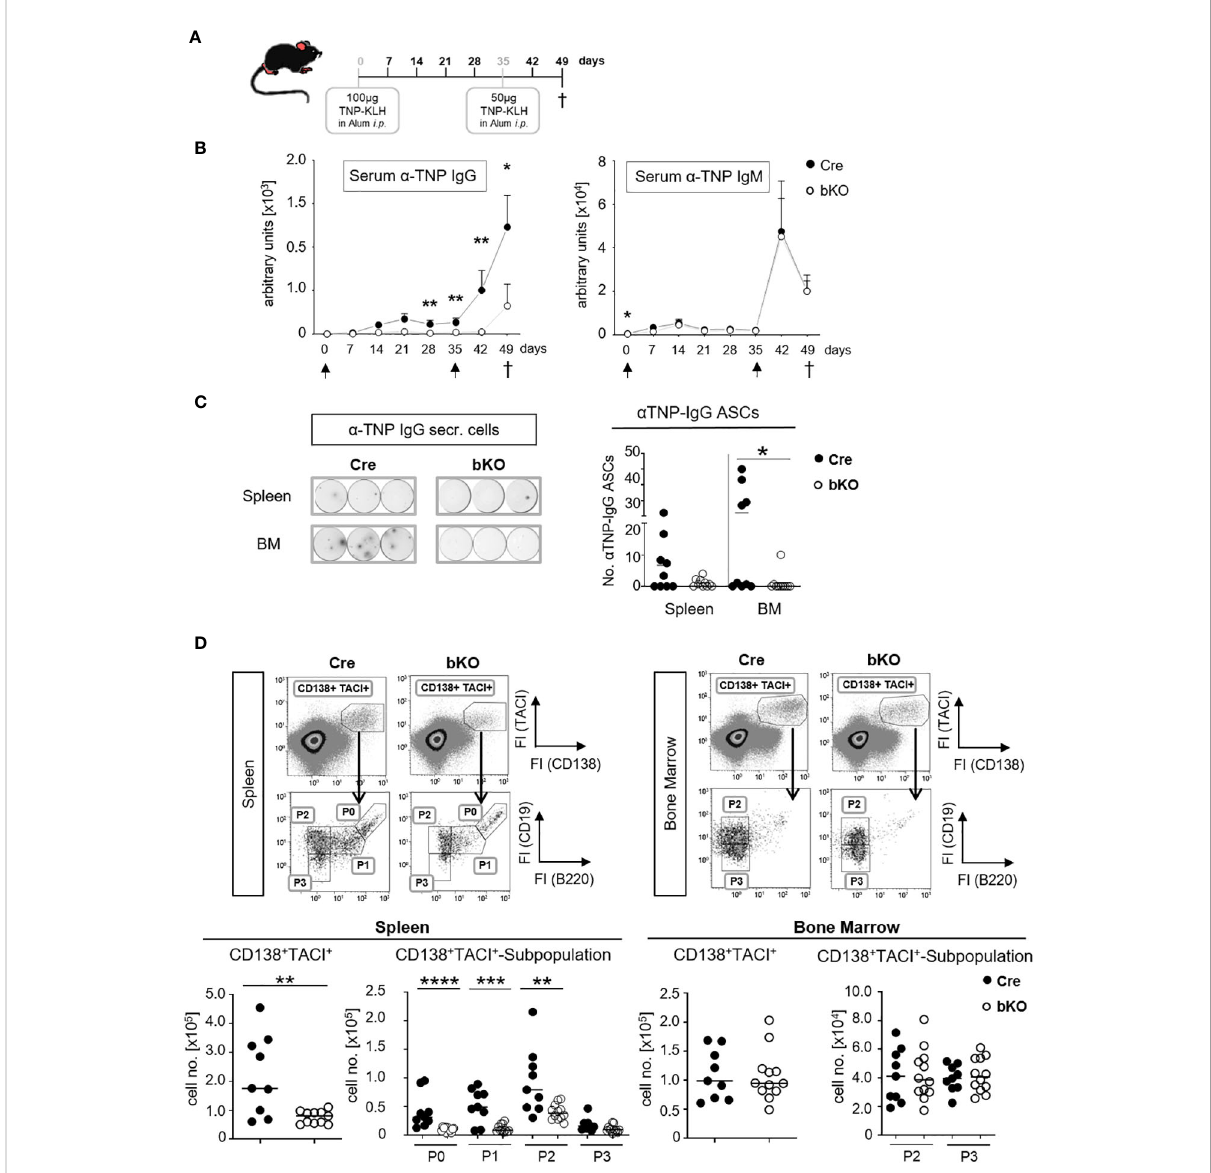
FIGURE 3 CD23-Cre-mediated DGCR8-de fi cient mice fail to mount a TD antigen-speci fi c IgG response. (A) DGCR8-bKO and Cre control mice (9-18 weeks in age) were injected intraperitoneally with TNP-KLH in alum, boostered on day 35 and sacri fi ced 49 days after primary immunization. (B) Blood was collected weekly, and sera were analyzed for TNP-speci fi c IgG and IgM by ELISA. Arrows indicate immunization time points. Each dot represents the mean (+SEM) of n=9 (Cre) or n=12 (bKO) mice. (C) Mice were sacri fi ced on day 49 p.i. (post-immunization), spleen and bone marrow (BM) cell suspensions were analyzed for TNP-speci fi c IgG-secreting cells by ELISpot assay. The examples show the results obtained from 6,67x10 5 cells incubated per well. Cell numbers are calculated per 2x10 6 seeded cells. (D) Flow cytometric analysis of splenic and bone marrow cells. Antibody-secreting cells were de fi ned as CD138 + TACI + cells and further divided by CD19 and B220 surface abundances in P0- activated B cells, P1-plasmablasts, P2-early plasma cells and P3-mature plasma cells (26). Cell numbers were calculated for one tibia and one femur or the entire spleen. (C, D) Bars indicate the median of n=9 (Cre) or n=12 (bKO) mice from N=3 experiments. Each dot represents an individual mouse. Maximal one signi fi cant outlier per genotype and analysis was removed from the analysis (Grubb ’ s test). The Mann-Whitney test was used for statistical analysis if the Shapiro-Wilk test showed no Gaussian distribution; otherwise, the t-test was used. *p<0.05; ** p<0.01; *** p<0.005; ****